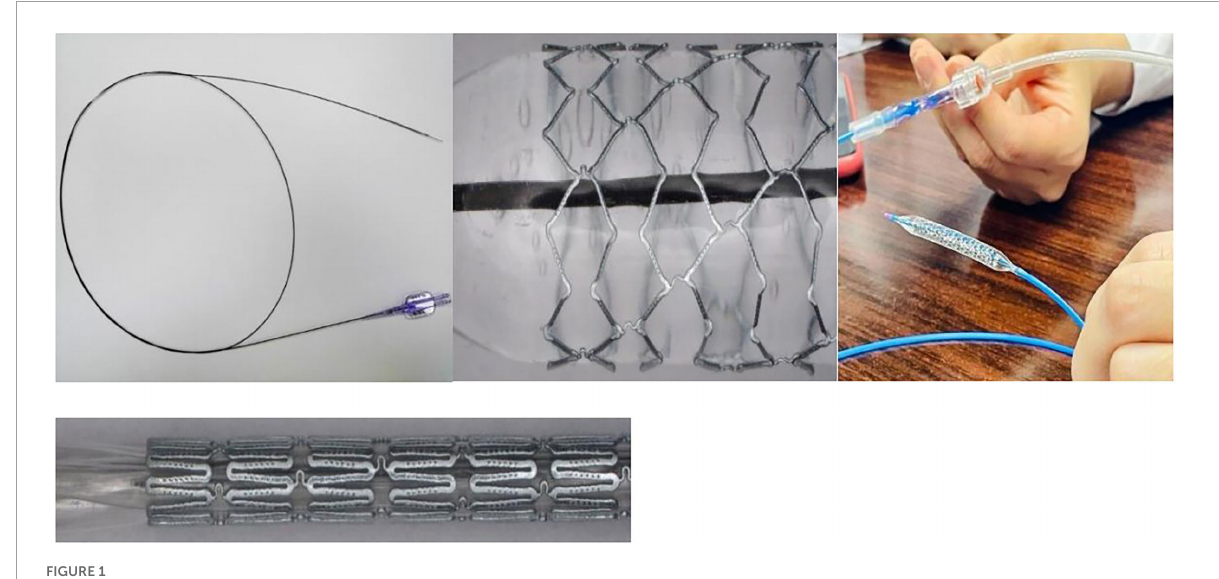
FIGURE1 IBS R (cid:13) Angel TM Stent